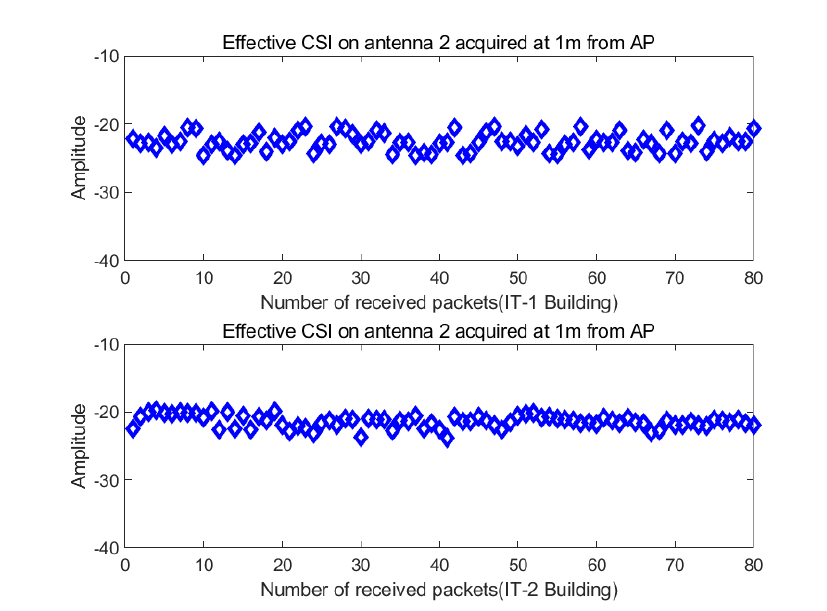
Figure 12. CSI effective values obtained on antenna 2 in different indoor